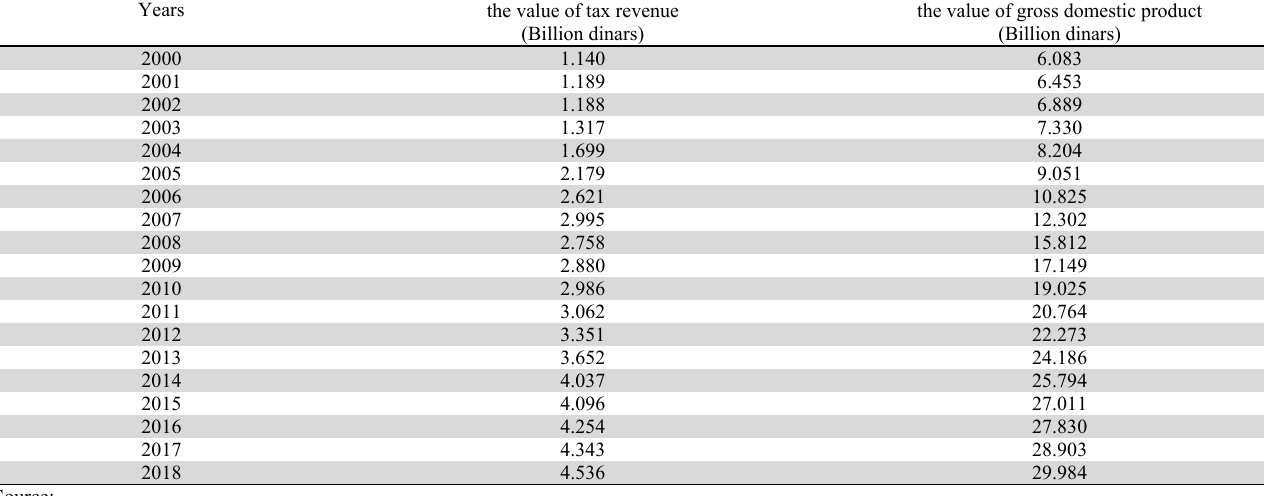
The value of tax revenues and the value of GDP in Jordan during the period (2000-2018) Years